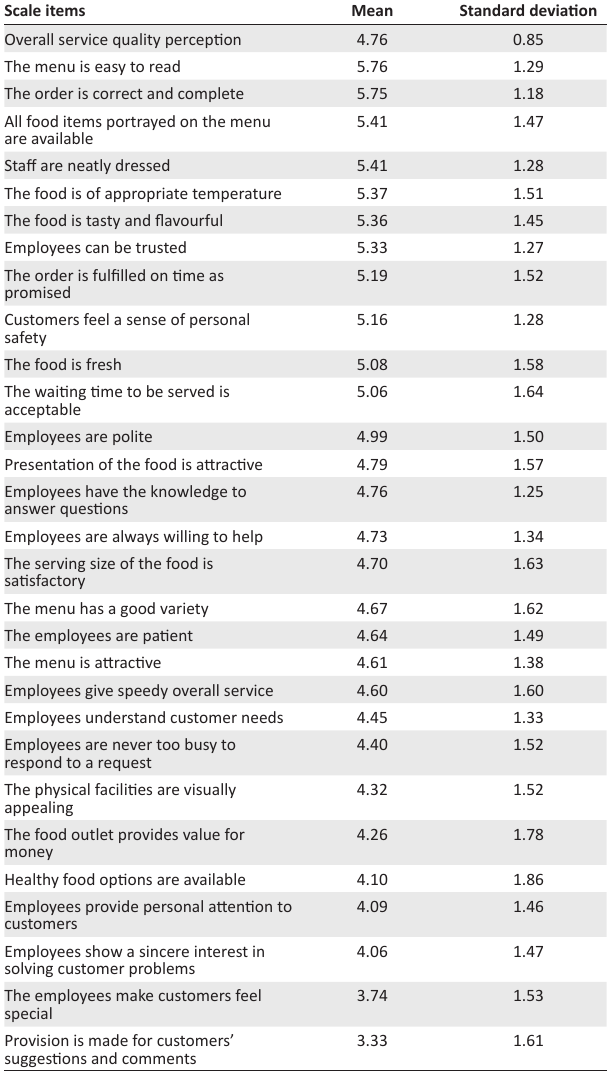
TABLE 4: Mean and standard deviation for items in the SERVQUAL/DINESERV scale ( N = 200). Scale items